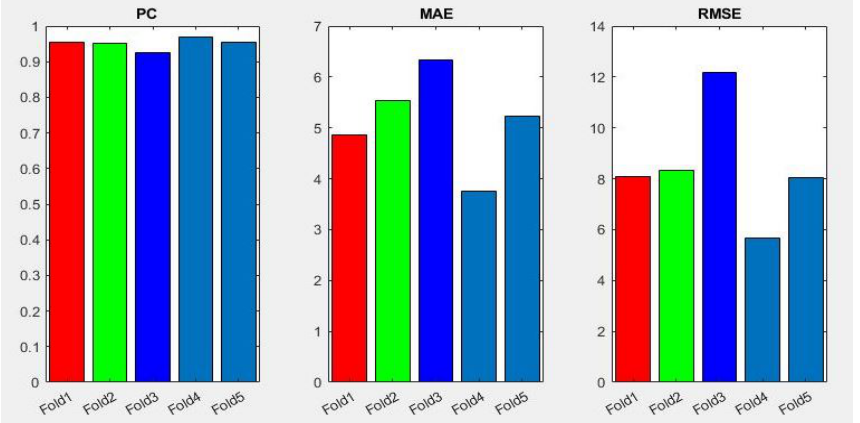
Figure 8. Summary of evaluation metrics results PC, MAE and RMSE for CNN Densenet-161 with optimizer RMSprop (testing